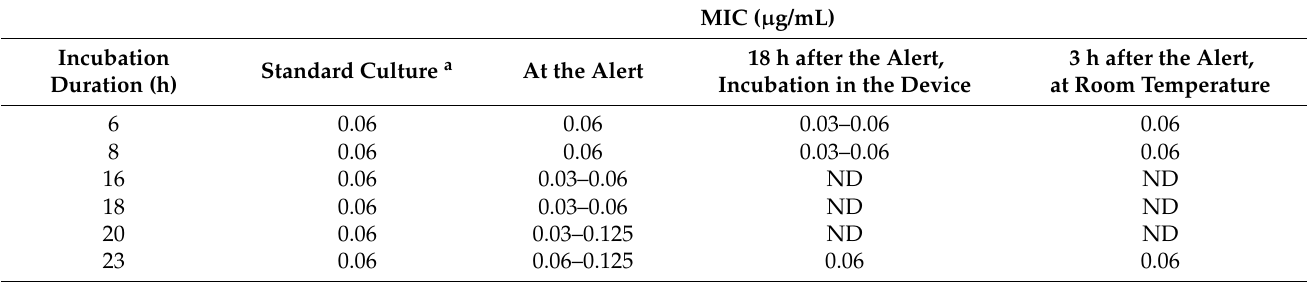
Table 6. Etest ciprofloxacin MIC values for B. anthracis -positive blood cultures. MIC ( µ